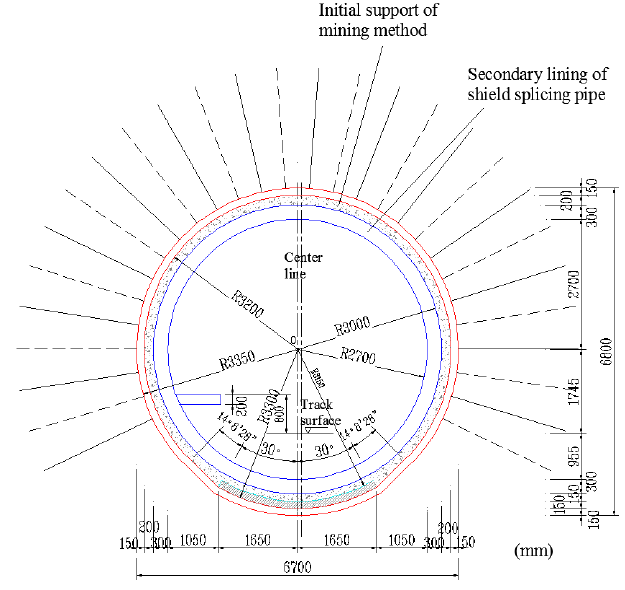
Figure 2. Transverse geological section of the tunnel project.